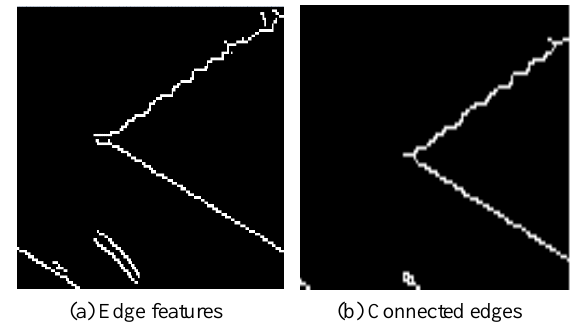
Figure 13. Edge features extracted from RGB